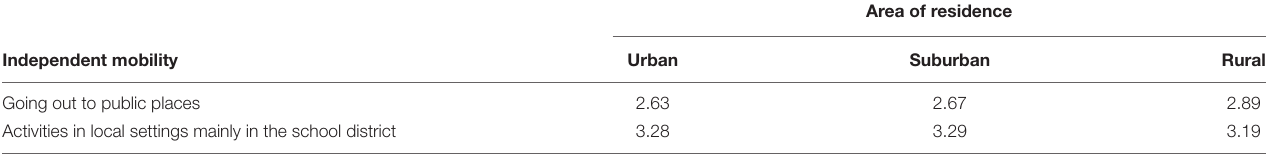
TABLE 5 | Associations of area of residence with independent mobility.